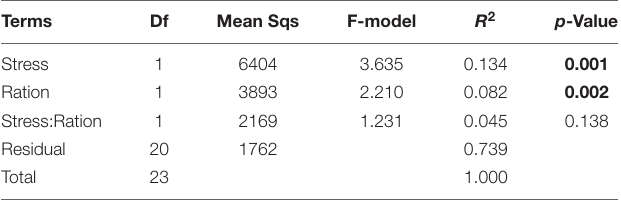
conditions of samples at day 4 of exposure using 999